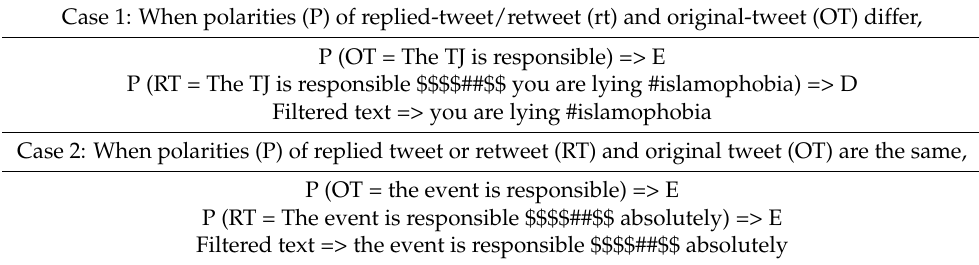
Table 2. Examples of polarity-based text